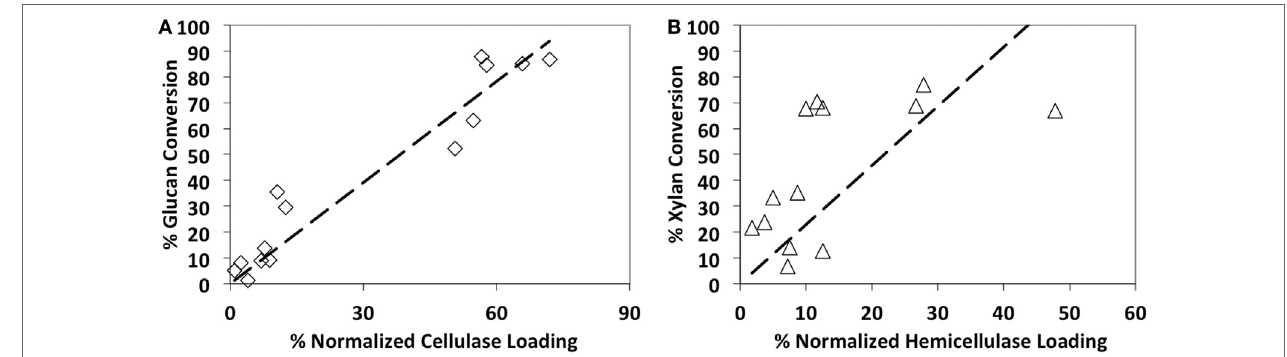
FigUre 2 | glucan-to-glucose (a) and xylan-to-xylose (B) percent conversions correlation to total available cellulases and hemicellulases loading, respectively . AFEX-treated corn stover was hydrolyzed using 14 commercial cocktails (60 mg/g glucan loading) for 24 h hydrolysis. Cellulase composition includes cellobiohydrolases, endocellulases, and β -glucosidase, whereas hemicellulase composition includes endoxylanases, arabinofuranosidases, α -glucuronidase, and β